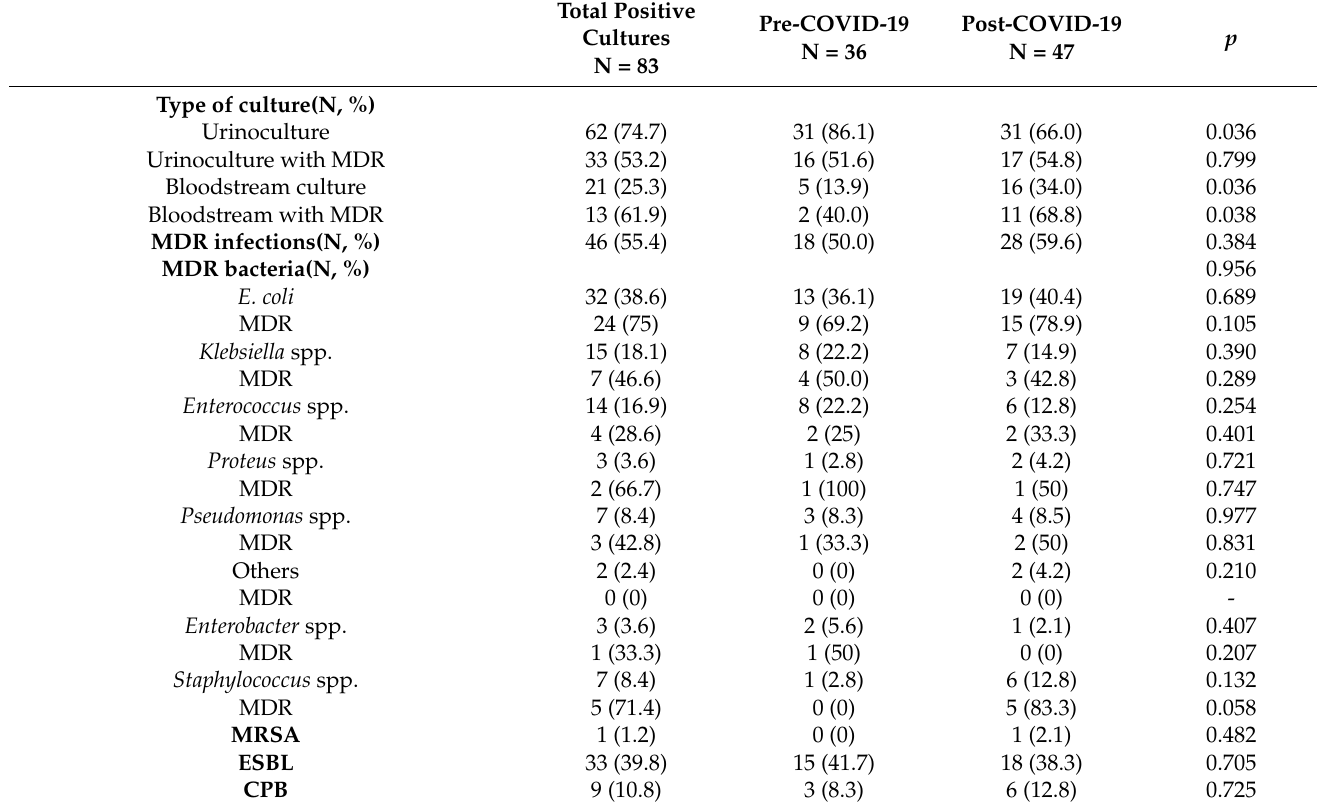
Table 2. Characteristics of cultures positive for bacterial infection taken in pre-COVID-19 and post-COVID-19 period. Total